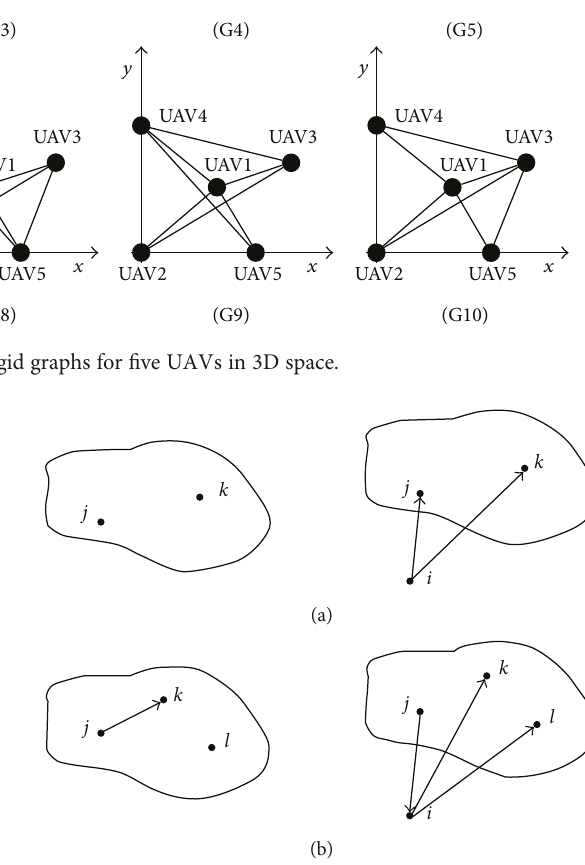
Figure 8: Two basic operations of rigid graph extension. (a)Vertex addition and (b) edge